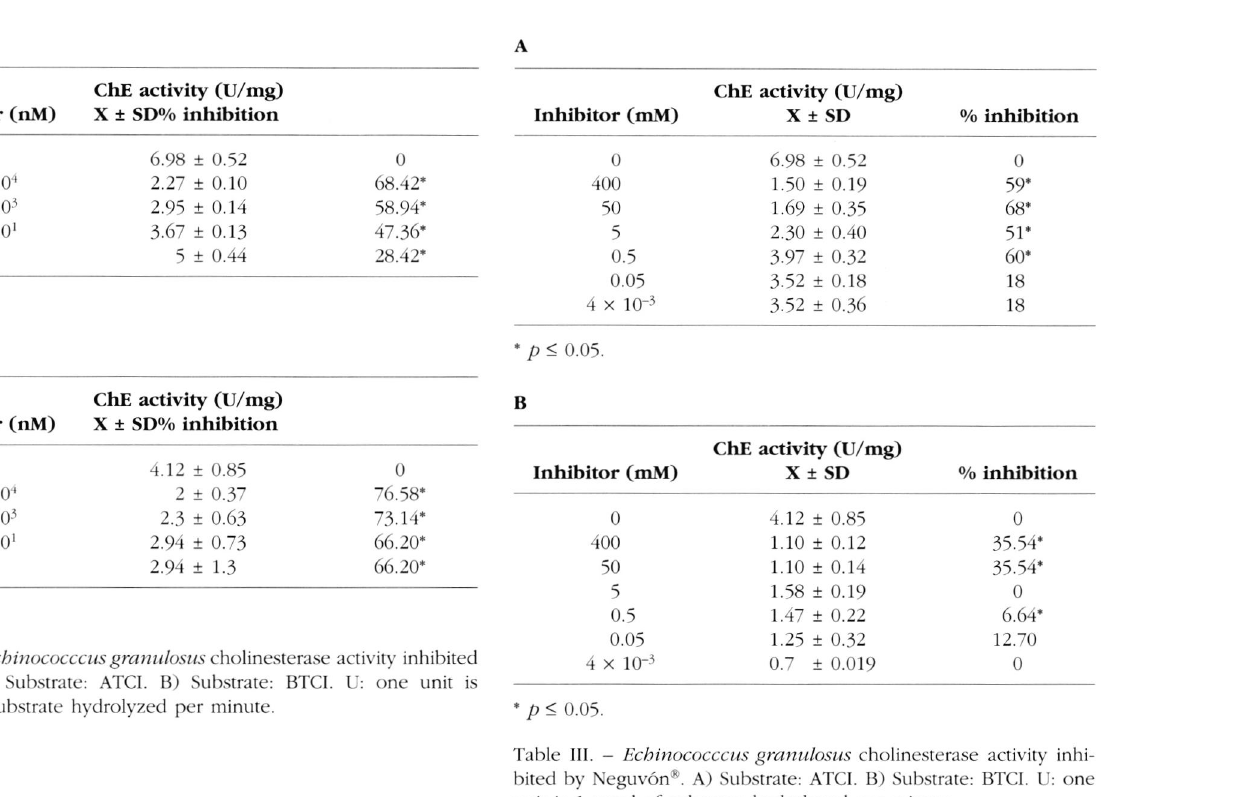
Table III. - Echinococccus